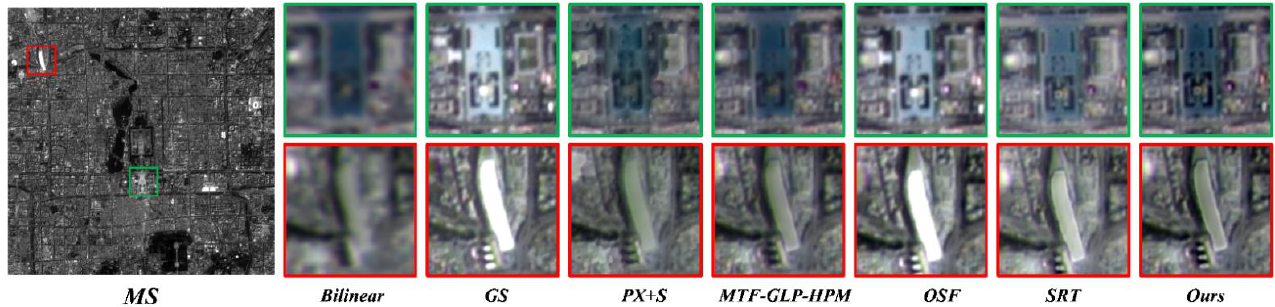
Figure 7. The results of different fusion methods for the Forbidden City area in Beijing are shown.